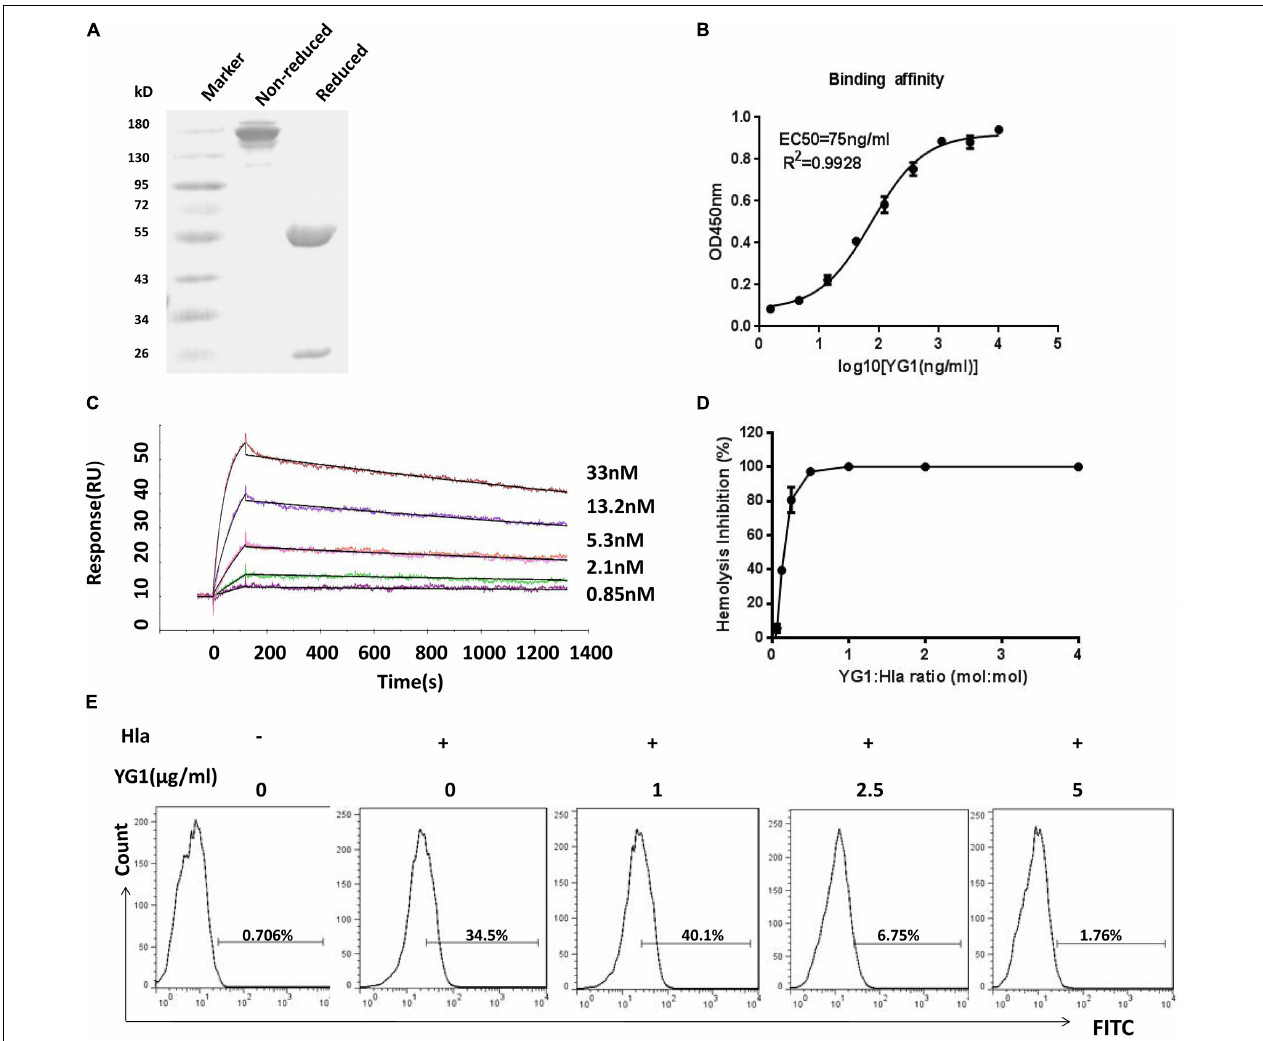
FIGURE 2 | Evaluation of YG1 function ex vivo . (A) SDS-PAGE analysis of the purified YG 1 mAb under reducing and nonreducing conditions. (B) The binding affinity of YG1 to Hla was determined by ELISA. Hla protein was coated onto 96-well plates, and YG1 was added at various concentrations. Bound IgG was detected using horseradish peroxidase (HRP)-conjugated goat anti-human IgG. (C) Antibody affinity of YG1 to Hla was determined with surface plasmon resonance (BlAcore). Anti-human IgG antibody was immobilized on the carboxymethylated dextran surface of a CM5 chip, and YG 1 was captured by the immobilized antibody. Hla protein was injected at the indicated concentrations. The data were analyzed using BlAcore X100 Evaluation software. (D) YG1 inhibited the hemolysis of red blood cells (RBCs) in a concentration-dependent manner. Serial dilutions of YG1 were incubated with Hla for 30 min at 37 ◦ C. The mixture was further incubated with rabbit RBCs for 1 h at 37 ◦ C. The samples were centrifuged, and the absorbance of the supernatants was measured at 405 nm. (E) YG1 inhibited Hla binding to A549 cells. Serial dilutions of YG1 (0, 1, 2.5, and 5 µ g/mL) were incubated with Hla for 30 min at 37 ◦ C. The mixture was further incubated with A549 cells (5 × 10 5 )